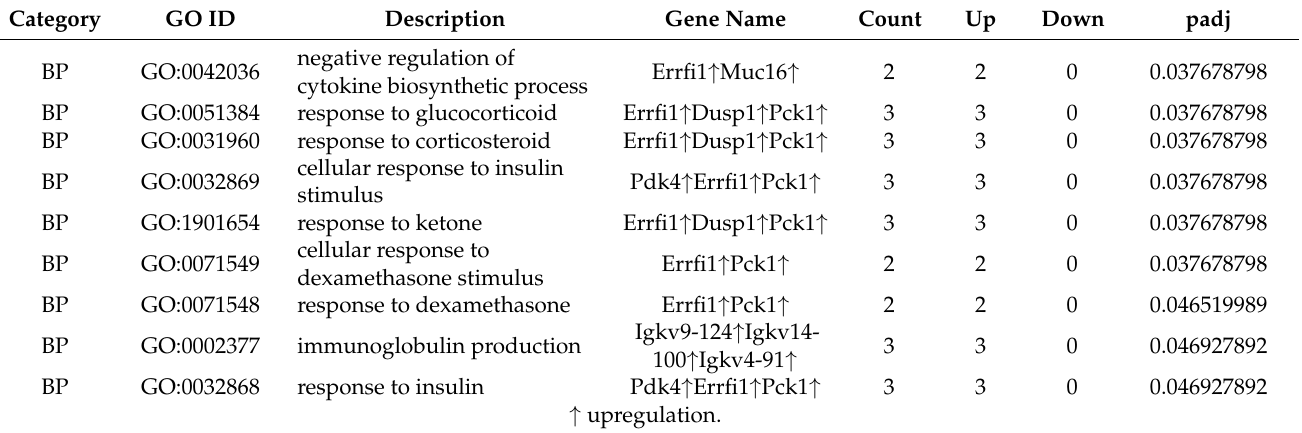
Table 2. List of GO terms enriched with splenic DEGs (padj < 0.05).